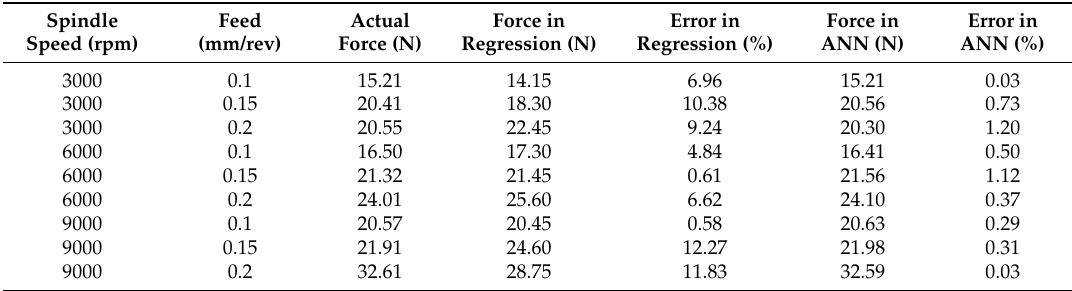
Table 8. Predicted cutting forces using regression model and ANN model for tool T1.